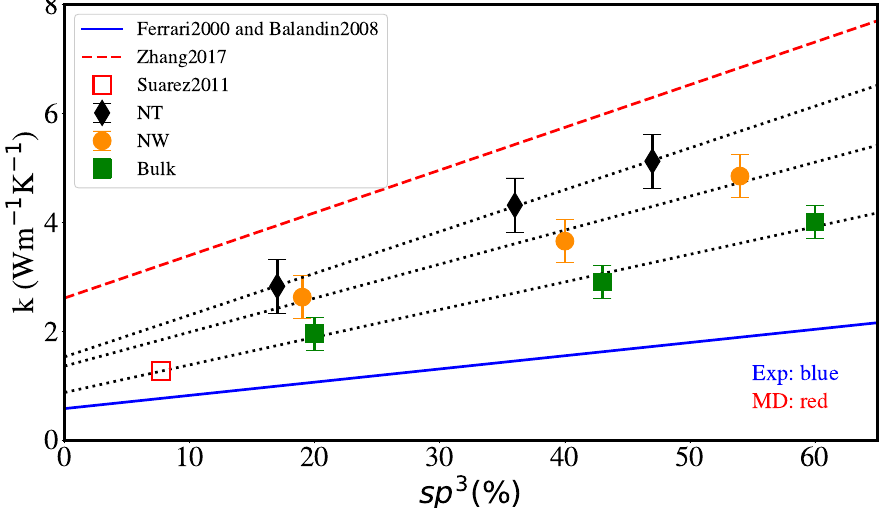
Figure 11. Thermal conductivity at 300 K vs. the percent of sp 3 hybridization for different geometries (the NT internal radius is 1 nm). Dotted lines show linear fits for the current MD values. There is also a MD result from [44], and the dashed line shows the fit to MD results using the Tersoff potential [42]. The solid line shows the linear relationship obtained from fits to experiments for aC thin films in Refs. [31,32].